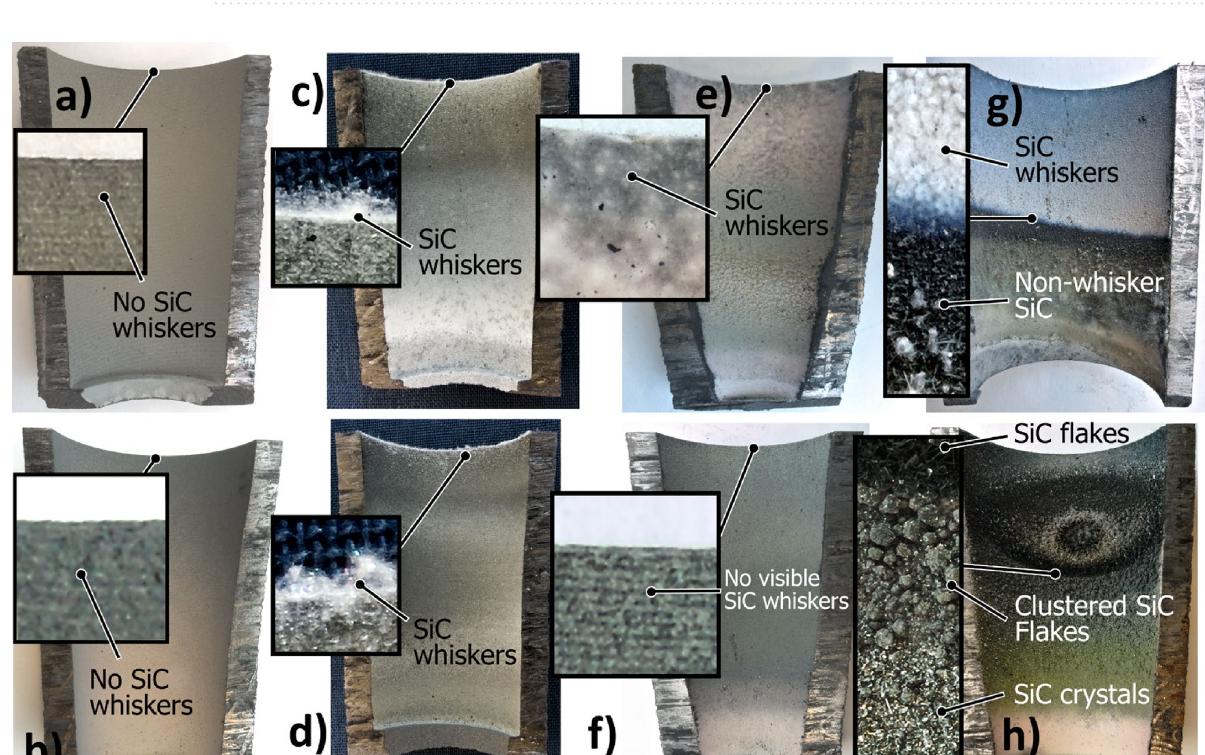
Figure 7. A comparison between crucible interiors after experiments (a) 1650 °C using Ar , (b) 1750 °C using Ar , (c) 1650 °C using pure H 2 , (d) 1750 °C using pure H 2 , (e) 1650 °C using 2% CH 4 in H 2 , (f) 1750 °C using 2% CH 4 in H 2 , (g) 1650 °C using 5% CH 4 in H 2 and (h) 1750 °C using 5% CH 4 in H 2